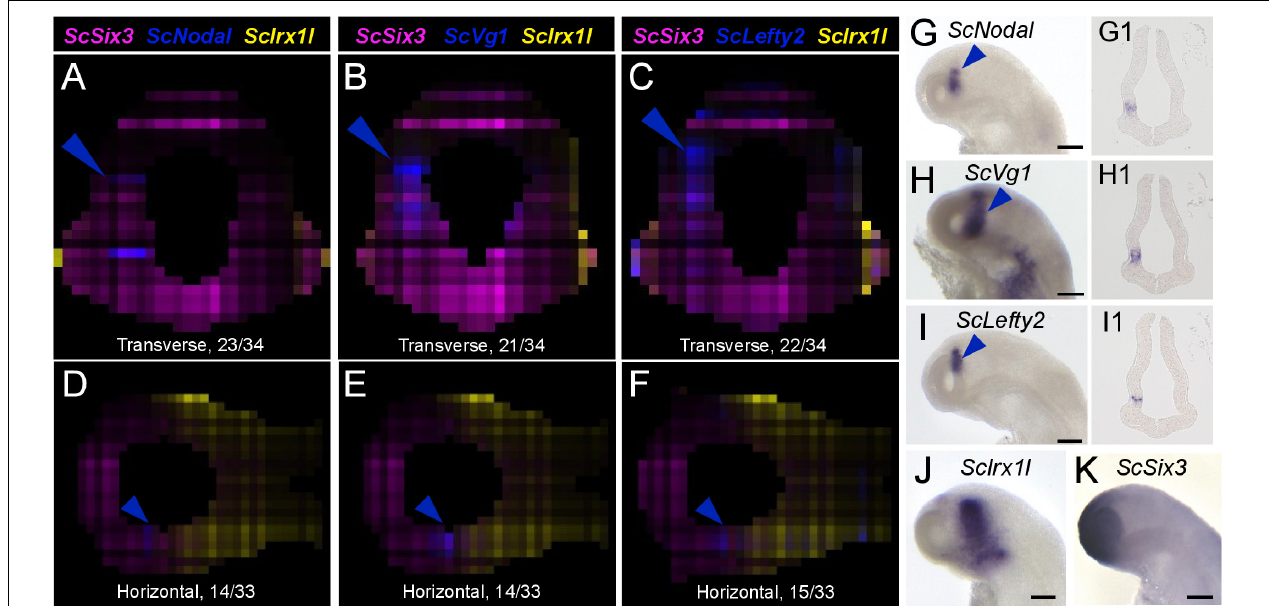
FIGURE 5 | Nodal signaling components exhibit left enriched profiles. (A–F) Digital transverse (A–C) and horizontal (D–F) sections showing merged profiles of ScSix3 (magenta), ScIrx1l (yellow), and in blue ScNodal (A,D) , ScVg1 (B,E) , ScLefty2 (C,F) . Sections are numbered from posterior to anterior in panels (A–C) and from dorsal to ventral in panels (D–F) . (G–K) Left lateral views of stage 17 catshark embryonic heads after whole-mount ISH with probes for ScNodal (G) , ScVg1 (H) , ScLefty2 (I) , ScIrx1l (J) , and ScSix3 (K) . (G1–I1) Horizontal sections of the brain of stage 17 catshark embryos after hybridization with probes for ScNodal (G1) , ScVg1 (H1) , ScLefty2 (I1) . Blue arrowheads point to ScNodal , ScVg1 , and ScLefty2 left-restricted digital or ISH signals in the dorsal diencephalon. Scale bars = 200 µ